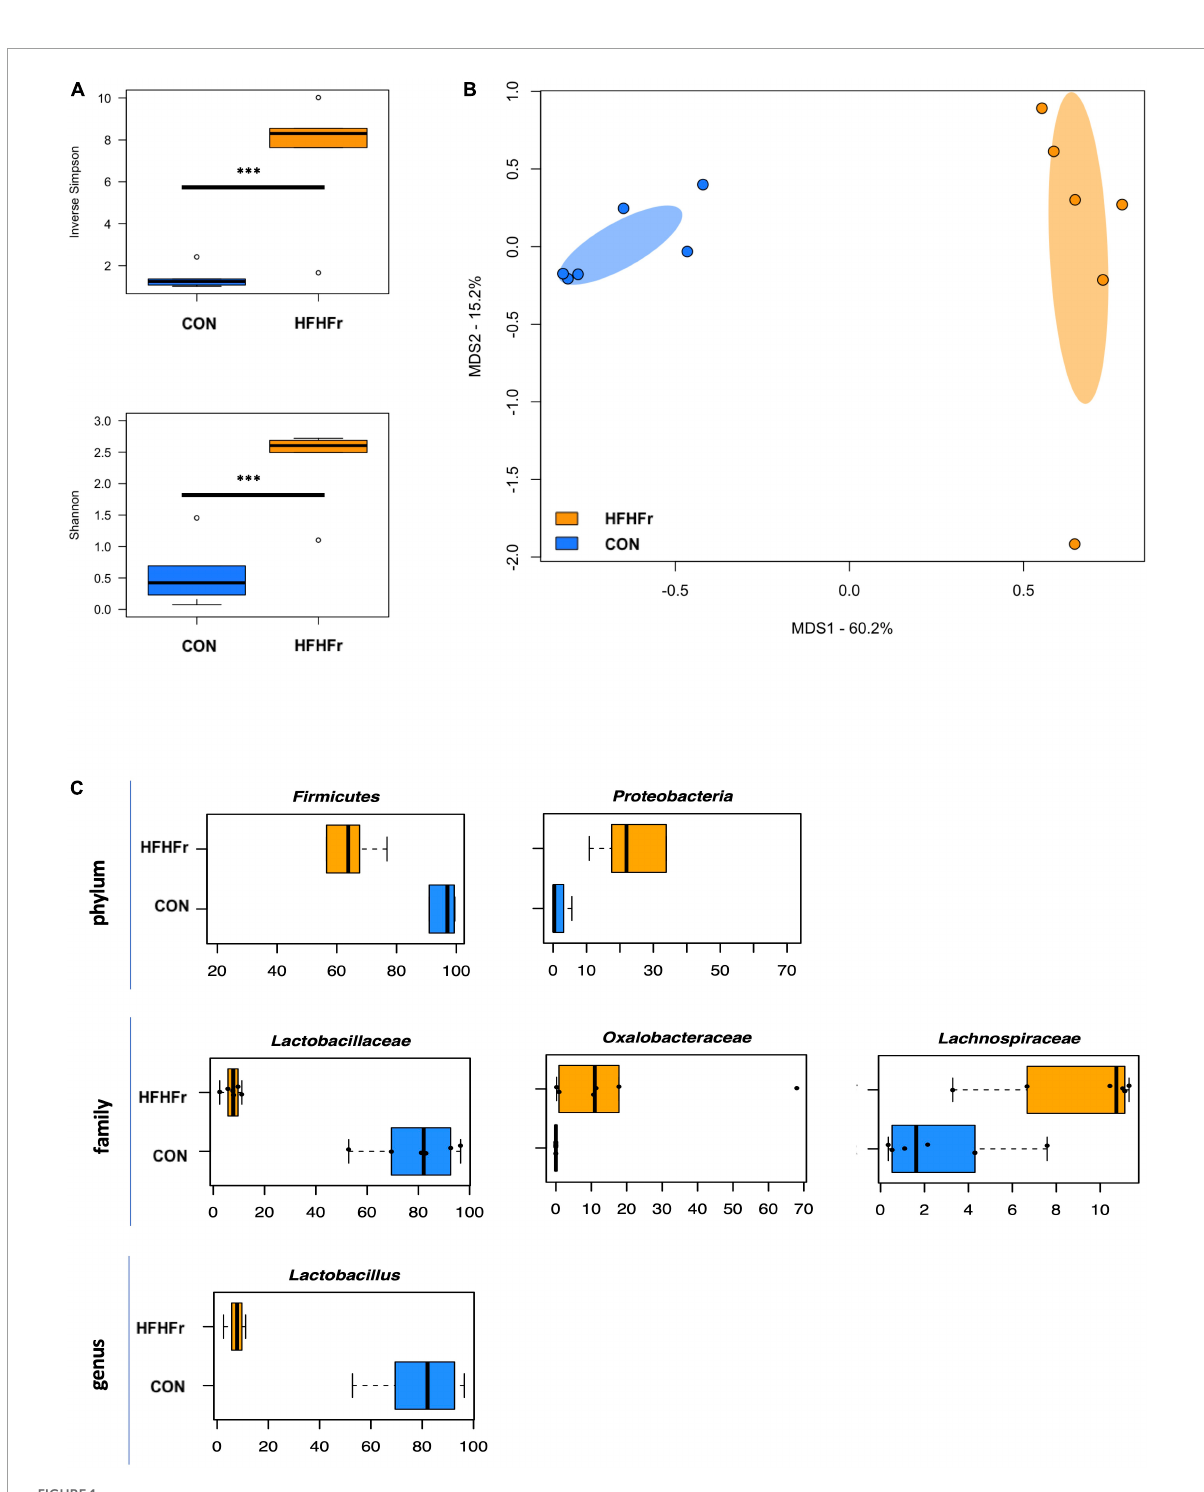
FIGURE1 The gut microbiota of mice fed a high-fat high-fructose diet segregates from that of control mice. (A) Boxplots showing the distribution of alpha diversity, according to the inverse Simpson (top) and Shannon (bottom) index, in mice fed a high-fat high-fructose diet (HFHFr) and control mice (CON). Greater diversity was found in HFHFr mice (*** P ≤ 0.004, Wilcoxon test). (B) Principal Coordinates Analysis (PCoA) of beta diversity, based on Bray-Curtis dissimilarity between the genus-level microbial profiles. A significant separation between groups was found ( P = 0.002, permutation test with pseudo-F ratio). Ellipses include 95% confidence area based on the standard error of the weighted average of sample coordinates. (C) Boxplots showing the relative abundance distribution of differentially represented phyla, families, and genera between study groups ( P < 0.05, Wilcoxon